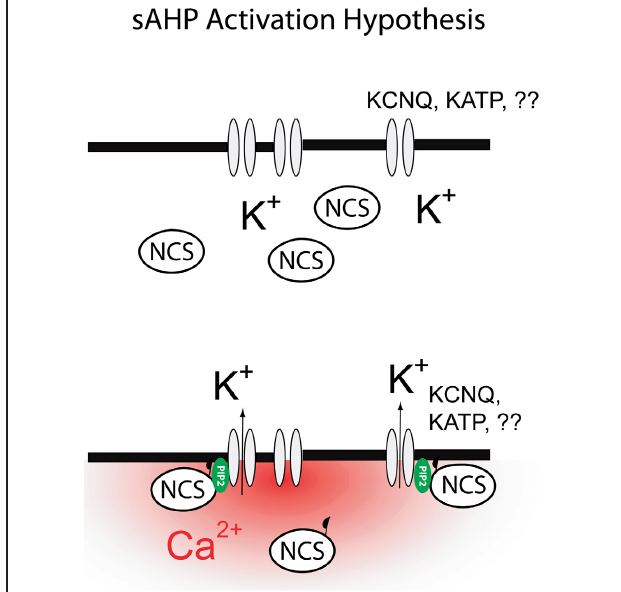
FIGURE 3 | Mechanism for the activation of the sAHP as proposed in this review. Global increases in cytosolic calcium lead to activation of diffusible neuronal calcium sensors (NCS: hippocalcin, neurocalcin δ ). Binding of calcium to NCS exposes a previously sequestered myristoyl moiety allowing NCS to bind to the plasma membrane. Binding of NCS to plasma membrane leads to a transient increase in PtdIns(4,5)P 2 levels and subsequent activation of the